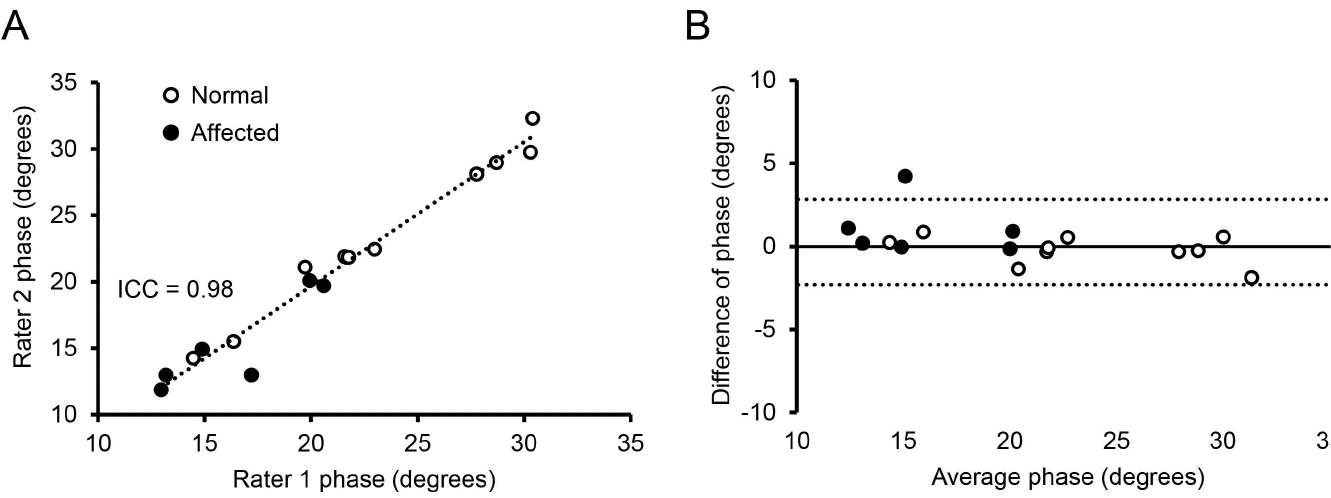
Fig 2. Inter-rater reliability of the EIM assay in normal and affected dogs. (A) The intra-classcorrelationplot of the two evaluators for phase at 150 kHz. (B) The Bland–Altman inter-rater plot. The solid line indicatesthe mean difference. Dashedlines mark standard deviations. Open circle, normal dogs; closed circle, affected dogs. Each circle represents one independent